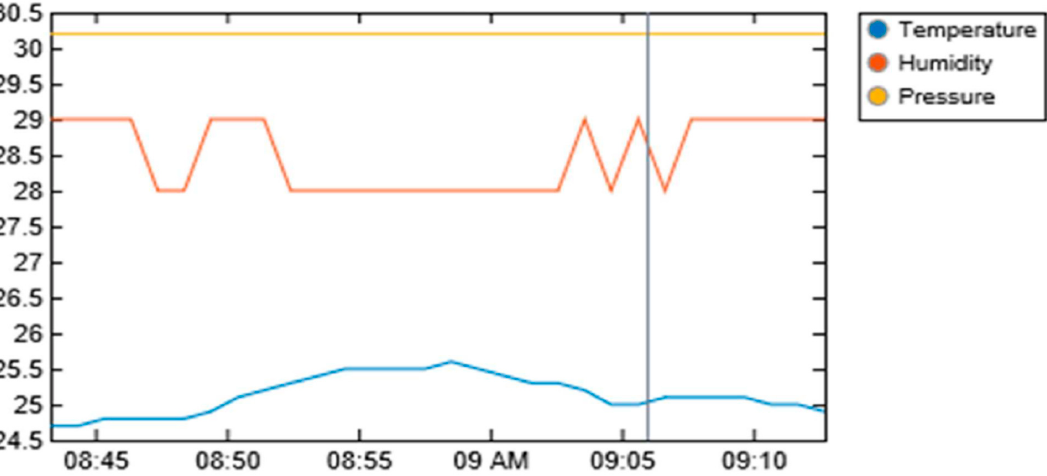
Figure 18. Variation of soil temperature, humidity, and pressure measurements obtained from http://www.thingspeak.com (API key = FE4H530DNA2NJQXB).